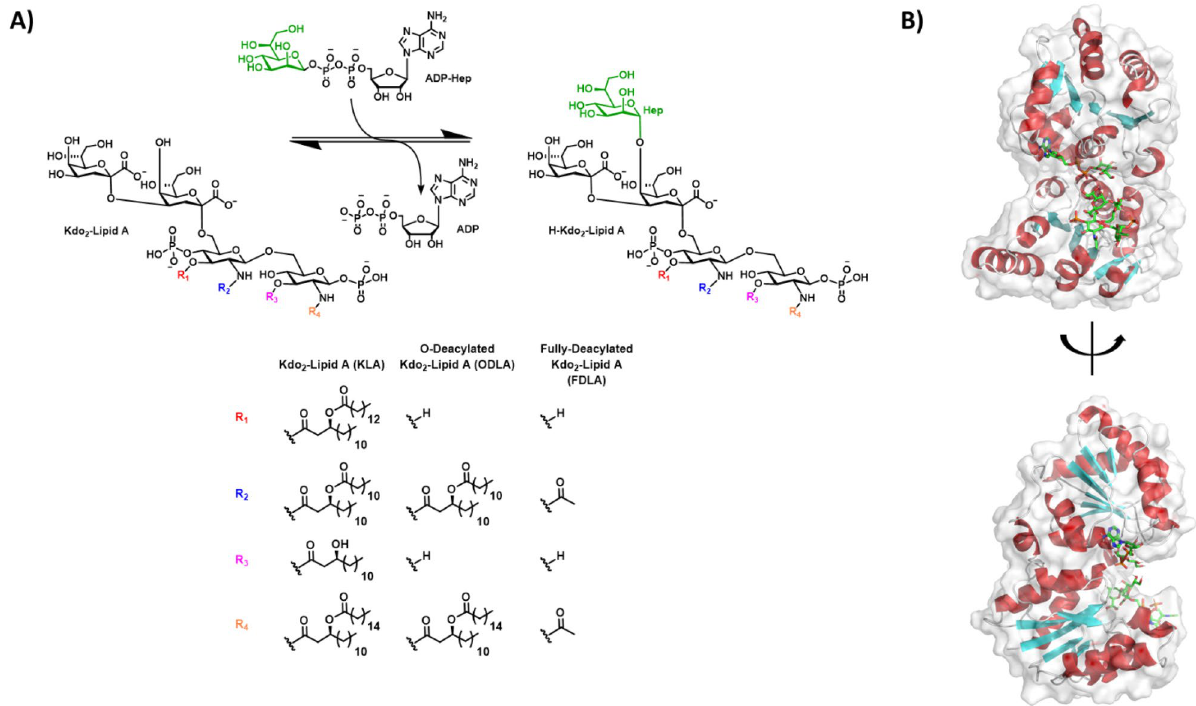
Figure 1. ( A ) Reaction catalyzed by Heptosyltransferase I with deacylated derivatives used in experiments (ODLA) and molecular dynamic simulations (FDLA) highlighted based on acyl substituents. ( B ) Fully bound substrate ternary model of Heptosyltransferase I colored by secondary structure (red: α-helix, cyan: β-strand, white: random coil).